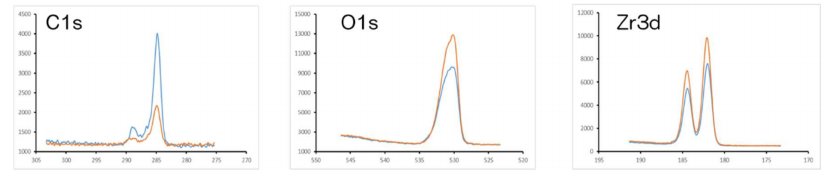
Figure 2. Orange line—test, blue line—control. The X-ray photoelectron spectroscopy (XPS) analysis of the surface UV-treated NANOZR and untreated NANOZR are shown. XPS analysis showed the increase in the O1s peak and decrease in the C1s peak on the surface of UV-treated NANOZR.